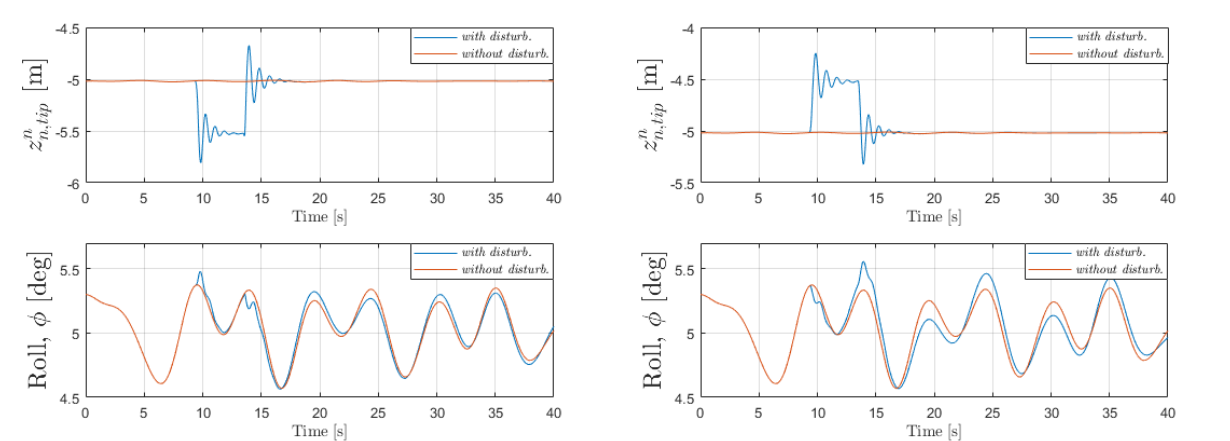
Figure 3: Upper window: The z coordinate of the crane tip, relative to and expressed in inertia frame { n } . The blue graph represents a sim- ulation where the crane tip is lifted up 0.5 m (along negative z -axis of inertia { n } ) after 10 seconds, and then lowered to initial position after 15 seconds. The red graph represents a simulation where the crane tip was kept sta- tionary. Lower window: Blue graph rep- resents the roll φ angle of the vessel due to disturbances (lift and lower operation) of the crane tip illustrated as blue graph in the up- per window. Red graph represents the roll φ angle of the vessel due to stationary crane tip.